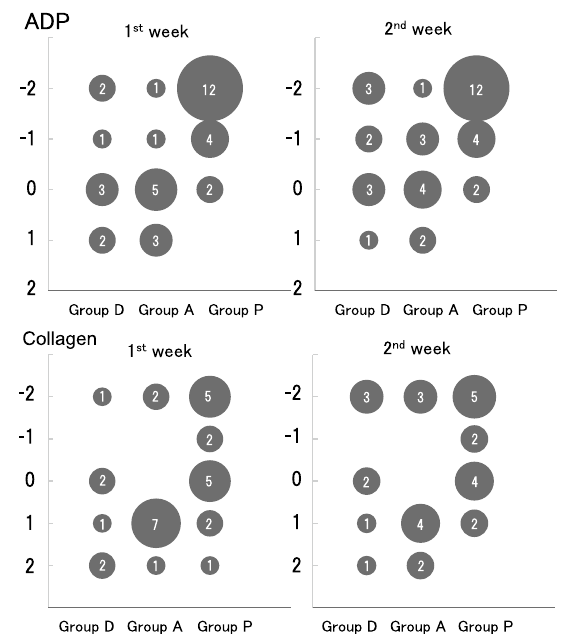
Fig. 3 Platelet aggregation activity elicited by ADP or collagen. The number of patients in whom platelet aggregation activity is reduced are increasing in 1 week in both groups D and A. This finding is observed in the same tendency as for elicitation by ADP and col- lagen. Bubble size and the number indicate the number of patients. Y axis expresses the degree of platelet coagulation activity. Negative number indicates reduced activity and positive number indicates accelerated